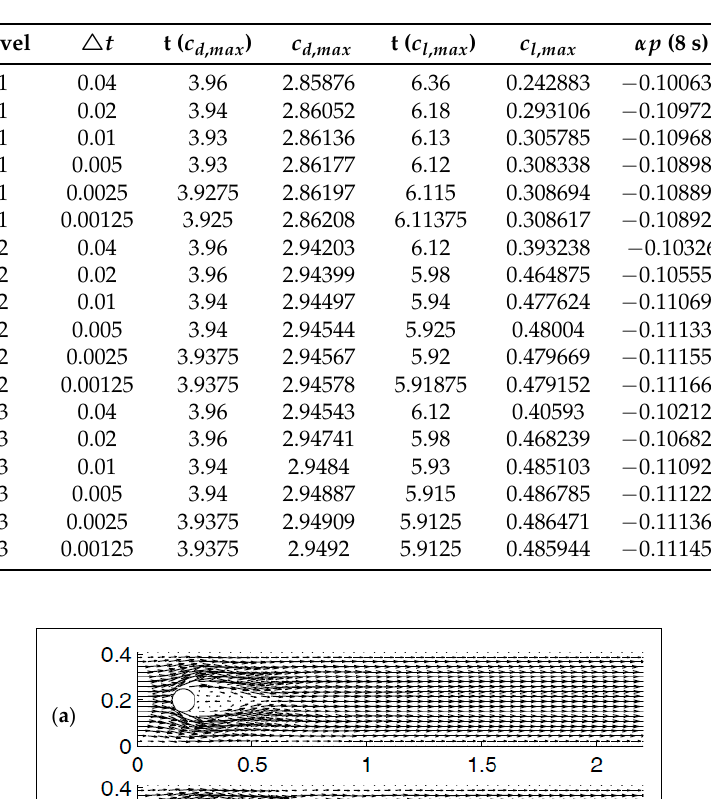
Table 2. Maximal drag, maximal lift, and change in pressure, order of deconvolution N = 0.